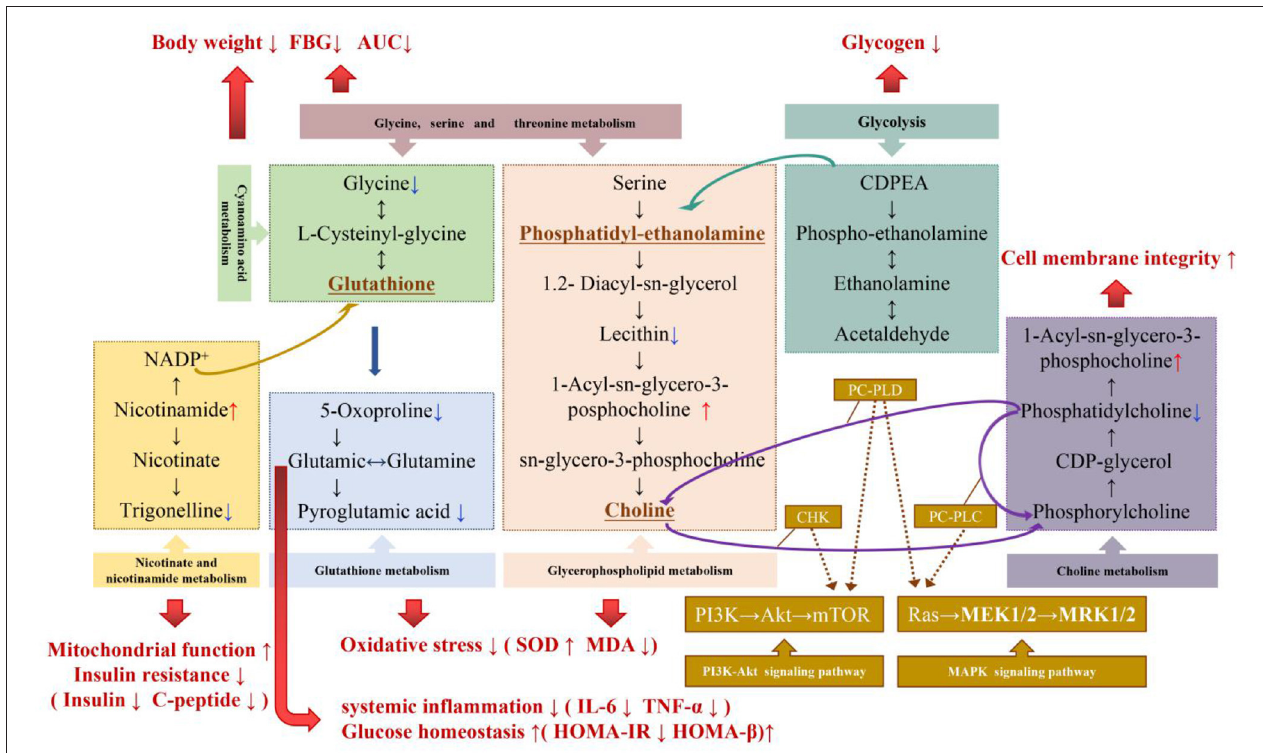
FIGURE 11 | Potential biomarker and metabolic pathways involved in the regulation of IR by MBPs. Metabolites that were significantly up-regulated were red, metabolites that were significantly down-regulated were